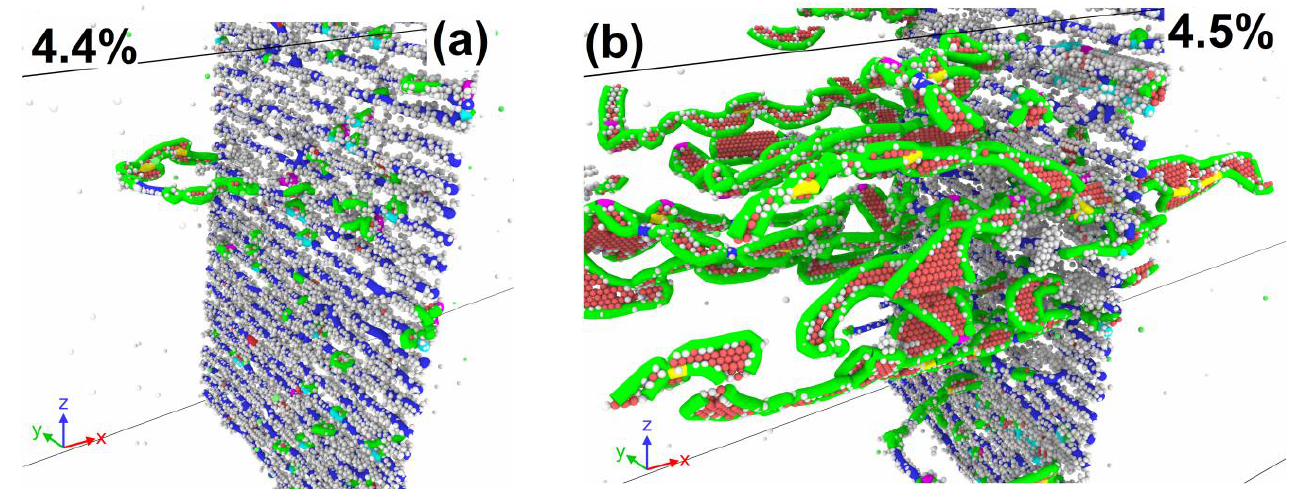
Figure 9. Deformation of system with 50% filling of three columns by Cu atoms (10.28 nm − 2 ). ( a ) Emission of dislocation semi-loop from GB into a grain. Only atoms with central symmetrical parameter exceeding 5 are shown. ( b ) Intensive dislocation emission from GB. GB retains a structure with gaps between dislocations in the wall without the formation of a disordered layer. Only atoms with central symmetrical parameter exceeding 5 are shown. Grey dots are FCC-type atoms, red—HCP. Dislocation structure is determined by DXA: blue lines are perfect dislocations, green — Shockley partials, light blue — Frank partials, purple — stair rod segments.